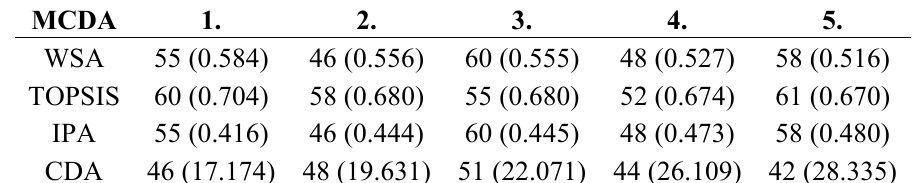
Table 12. Final MCDA scores for overall evaluation of all floor structure alternatives.